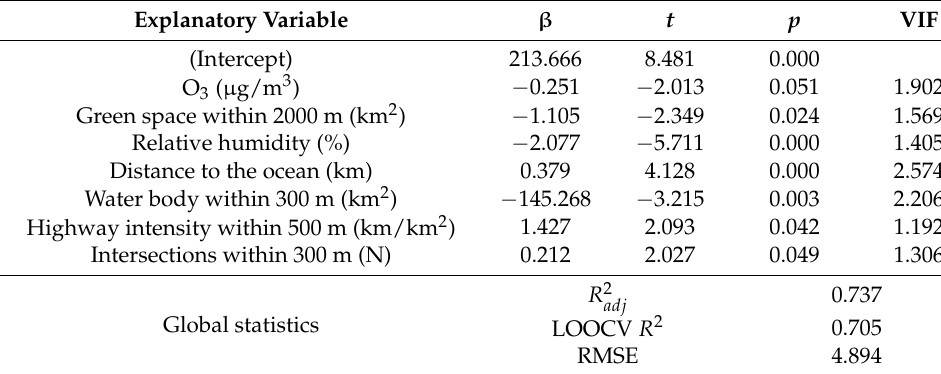
Table 8. Final results of the NO 2 model for the evening peak (5 p.m.–7 p.m.).